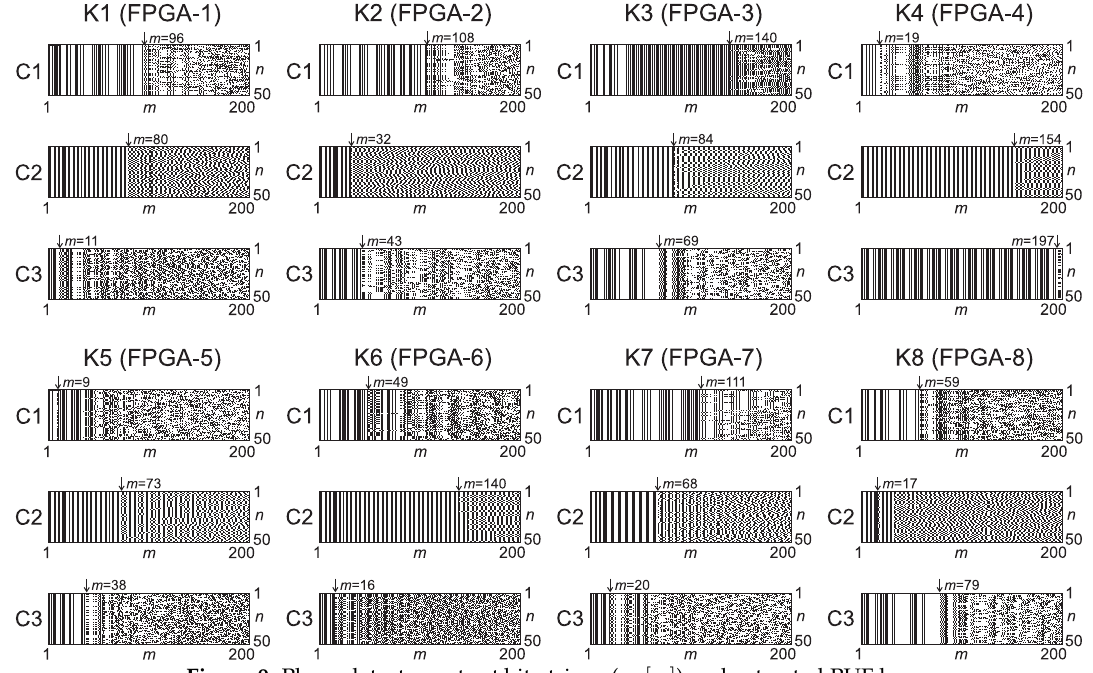
Figure 9. Phase detector output bit-strings ( s N [ m ] ) and extracted PUF